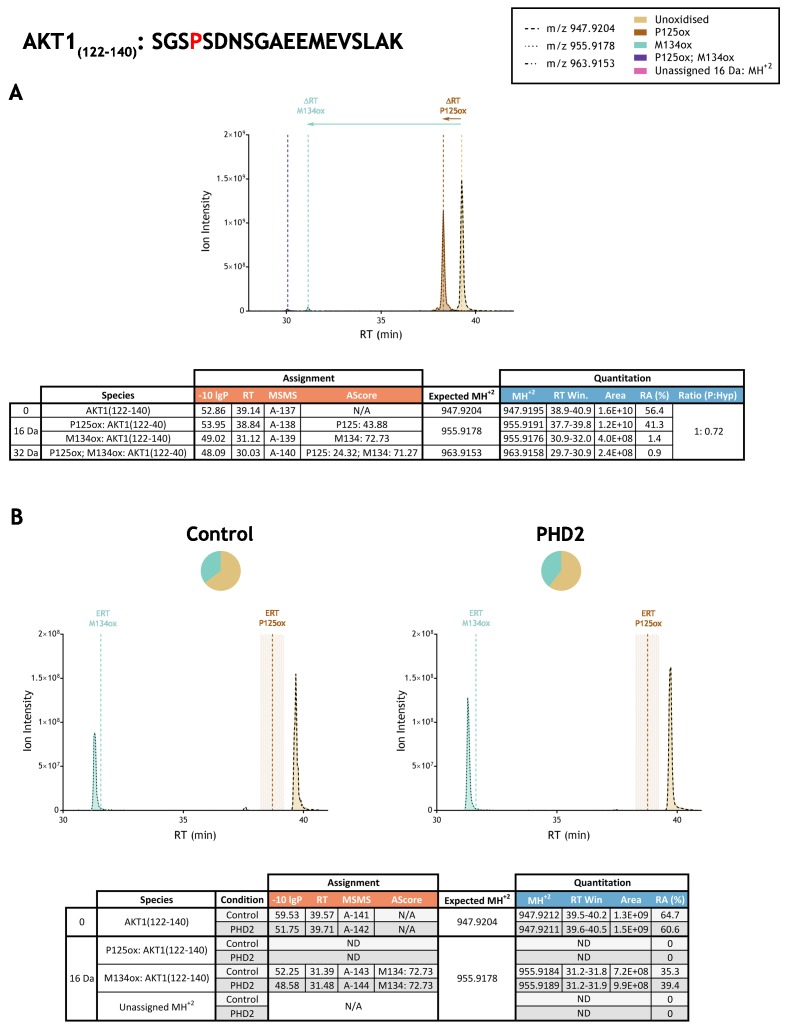
Quantitation of peptide oxidation on AKT1(122–140) following reaction of full-length AKT serine/threonine kinase 1 with recombinant PHD2.XIC data presented in (A) shows ion intensity and retention time (RT) characteristics of equimolar synthetic peptide standards for unoxidised and P125ox forms of the AKT1(122–140) peptide. MSMS assigned species are coloured (see inset) and include low abundance non-enzymatic methionine oxidation (M134ox; turquoise); vertical dashed lines define peak maxima used to derive ΔRT values for P125ox and M134ox. Panel (B) shows comparable XIC data for protease-digested IVTT substrate under control (left) or PHD2-reacted (right) conditions. Peaks corresponding to unoxidised and M134ox forms of AKT1(122–140) were assigned by MSMS; P125ox was not detected. Estimated RT (ERT) values for oxidised peptides, derived from (A), are indicated by dashed vertical lines and show IVTT-derived M134ox eluting close to the ERT; shading applied to ERT P125ox corresponds to a 1 min RT window. Unassigned ions of compatible mass over charge for hydroxylation were not observed across the elution window. Quantitative data for observed species are presented as pie charts with XIC data. Assignment and quantitation data are tabulated below each panel, table headers are as follows: (−10lgP) significance score of leading assignment at given (RT) with ambiguity score (AScore) for PTM localisation and reference to primary MSMS data in Supplementary file 1. Quantitative data reports ion counts (Area) of observed masses (MH+2) integrated over time (RT Win.), expressed as relative abundance (RA). Data on detection efficiency for synthetic peptides (Panel A, P: Hyp) is an aggregated ratio of prolyl (P) to hydroxyprolyl (Hyp) containing species.